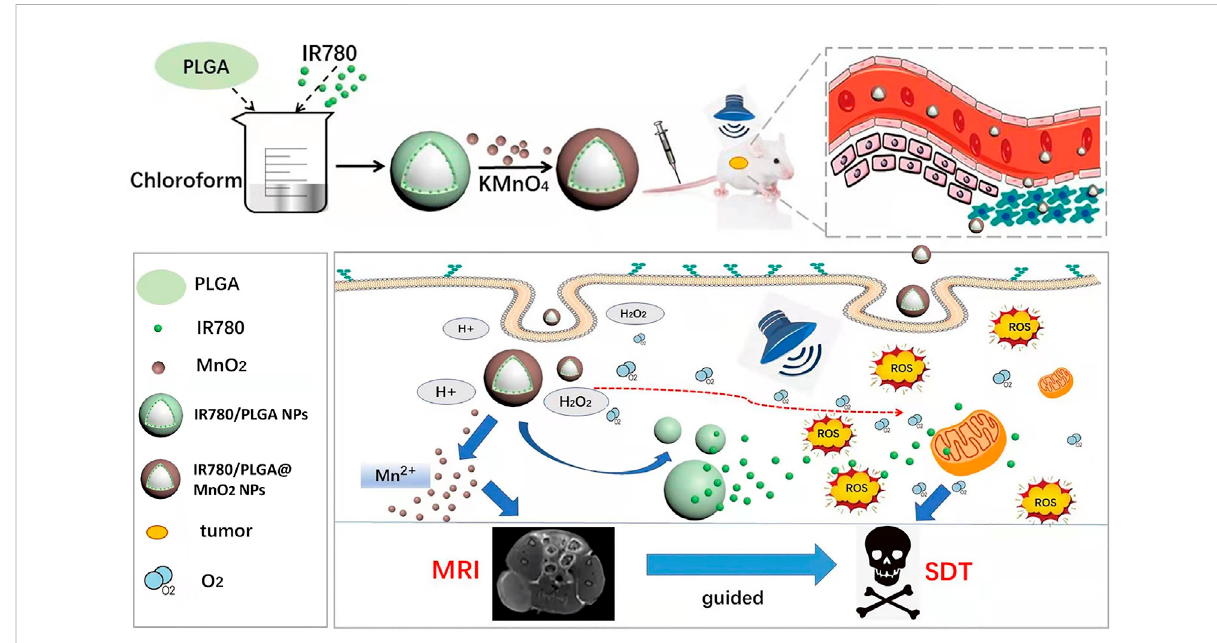
FIGURE 1 Schematic illustration of the IR780/PLGA@MnO 2 NPs used for enhance SDT and MR imaging of breast cancer.